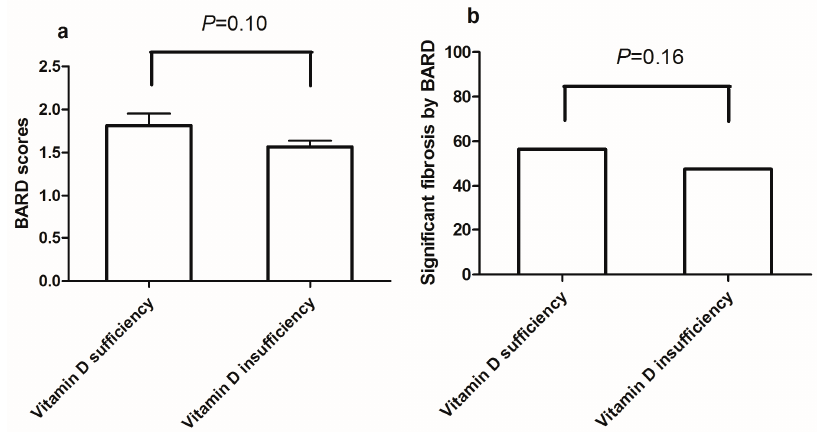
Figure 2. ( a ) BARD scores vs. vitamin D status; ( b ) significant fibrosis defined by BARD score vs. vitamin D status.